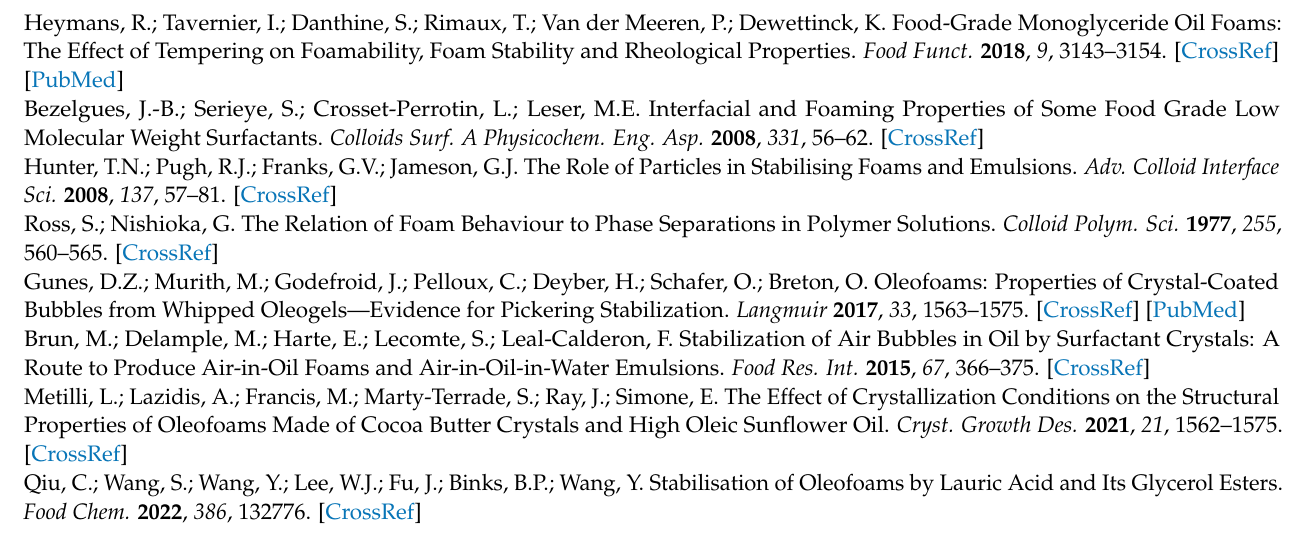
10 ◦ C/min; Figure S3: Raw materials cooling curves as obtained by Differential Scanning Calorimetry for cooling rate of 10 ◦ C/min; Figure S4: Relative crystallinity (quantified by DSC data) plotted as a function of temperature: (A) 20 GMS, (C) 20 GMS/1 GMO, (E) 20 GMS/2.5 GMO, and (G) 20 GMS/5 GMO; and as a function of time: (B) 20 GMS, (D) 20 GMS/1 GMO, (F) 20 GMS/2.5 GMO, and (H) 20 GMS/5 GMO, for non-isothermal crystallization at cooling rates from 1 to 20 ◦ C/min; Figure S5: Half time crystallization ( t 1/2 ) of the different formulations vs cooling rate; Figure S6: Complex viscosity η * plotted as a function of temperature: (A) 20 GMS, (C) 20 GMS/1 GMO, (E) 20 GMS/2.5 GMO, and (G) 20 GMS/5 GMO. Relative crystallinity (quantified by rheology data) plotted as a function of time: (B) 20 GMS, (D) 20 GMS/1 GMO, (F) 20 GMS/2.5 GMO, and (H) 20 GMS/5 GMO, for non-isothermal crystallization at cooling rates from 1 to 20 ◦ C/min; Figure S7: Polarized Microscopy images of the different samples, obtained directly after cooling at different cooling rates. (A) Scale bar at 20 µ m and (B) scale bar at 100 µ m. Linear enhancement of the same level was applied to all micrographs; Figure S8: OBC values of the different formulations, for two centrifugation times; Figure S9: MCT oil oleofoams composed of (A) 20% GMS, (B) 20% GMS/1% GMO, (C) 20% GMS/2.5% GMO, and (D) 20% GMS/5% GMO; Figure S10: Overrun values (%) after 5 min of whipping; Figure S11: Polarized Microscopy micrographs of the prepared foams directly after the whipping process. (Scale bar at 20 µ m and 100 µ m). Linear enhancement of the same level was applied to all micrographs; Figure S12: DSC data as they were obtained by the DSC instrument. These data were used for the analysis described by Figure